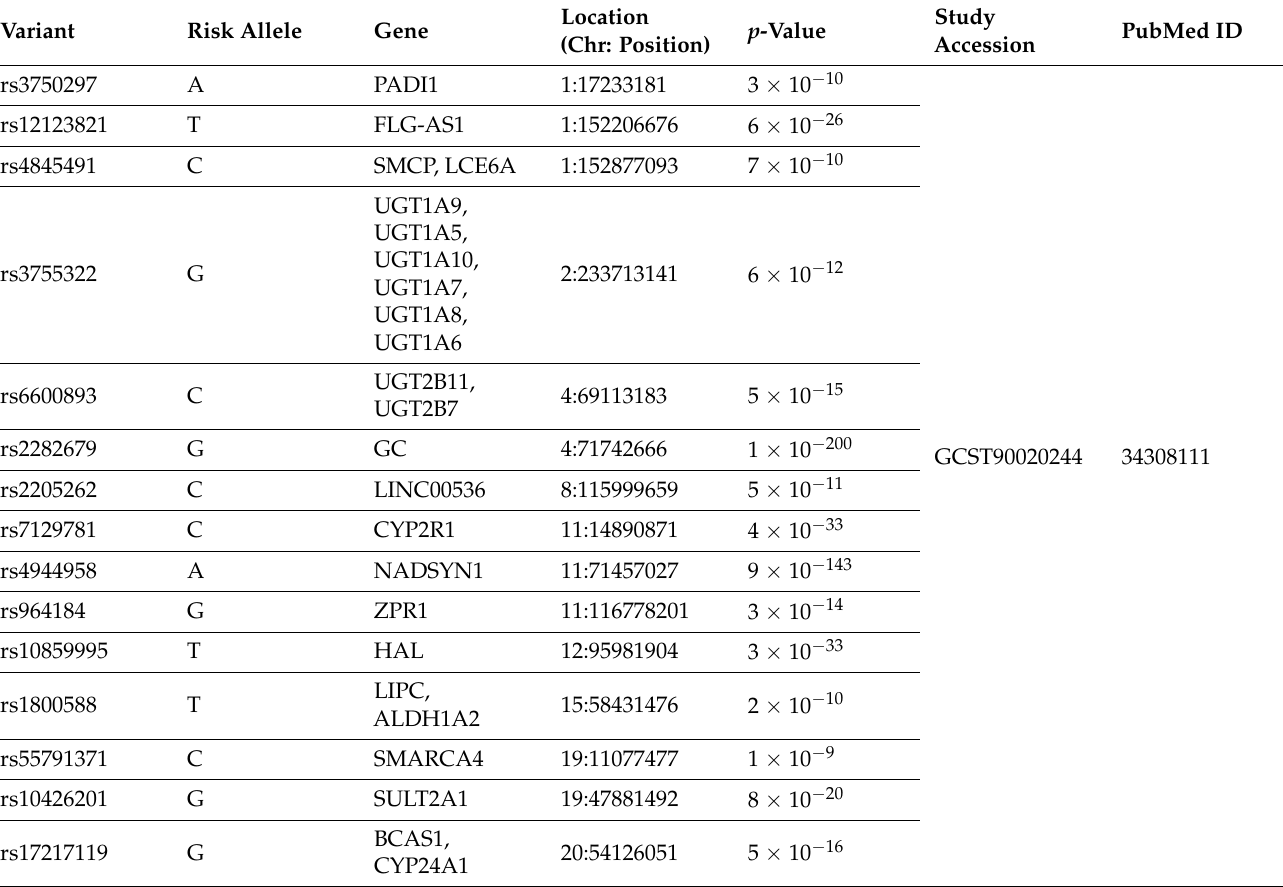
Table 1. Genes and variants associated with a VD deficiency. Information on the genes to which these variants belong, the risk allele of each SNP, location in the genome (chromosome: chr) for the hg38 coordinates, and the p -value (existing degree of significance between that variant and the